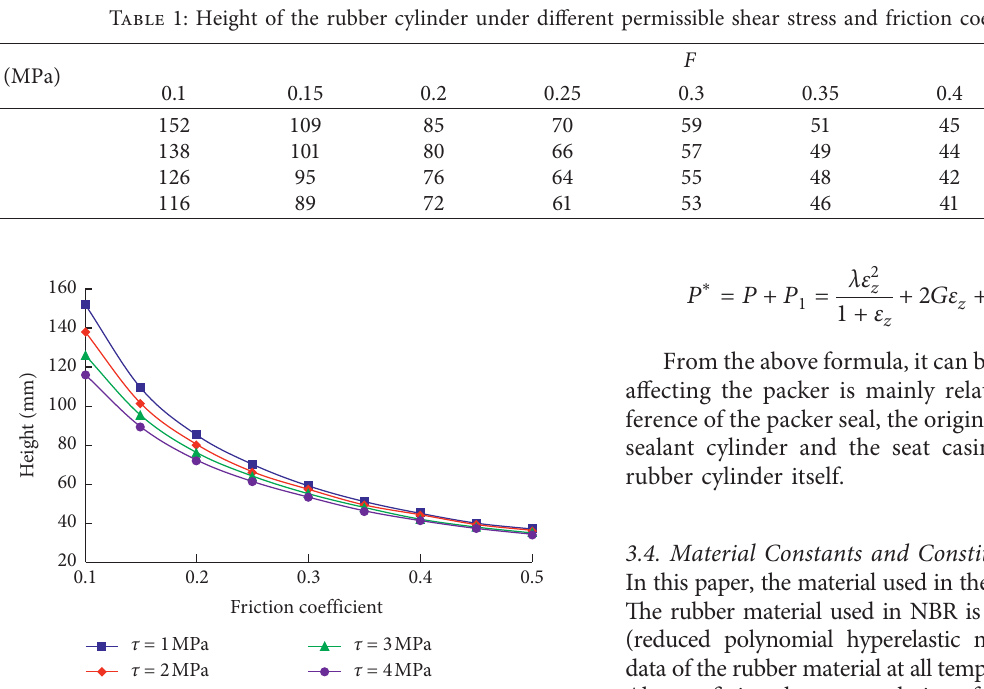
Figure 6: The height of the rubber cylinder varies with shear stress under different friction